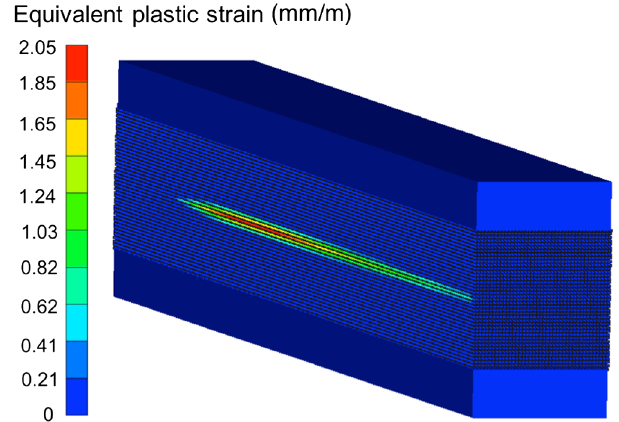
FIG. 15. Plastic deformation in TCTH.4L1.B1 simulated by AUTODYN for Case 2. The picture shows the plastic strain profile corresponding to the onset of permanent damage in the jaw (threshold 1), reached after the impact of the last proton